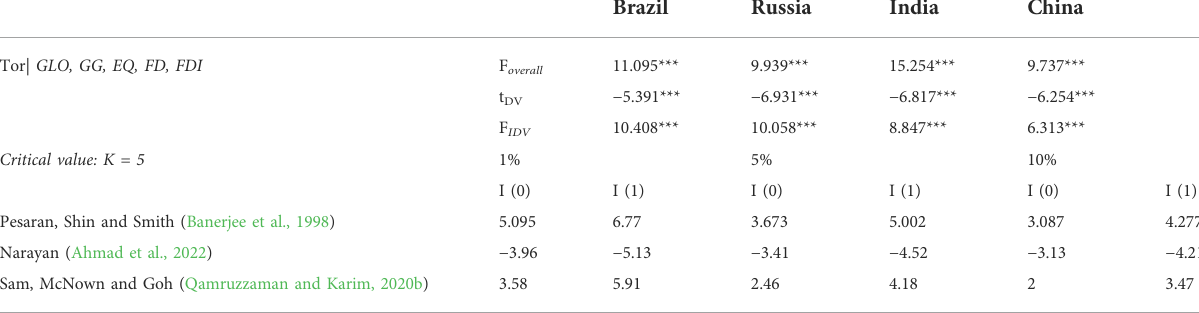
TABLE 5 Results of long-run cointegration.